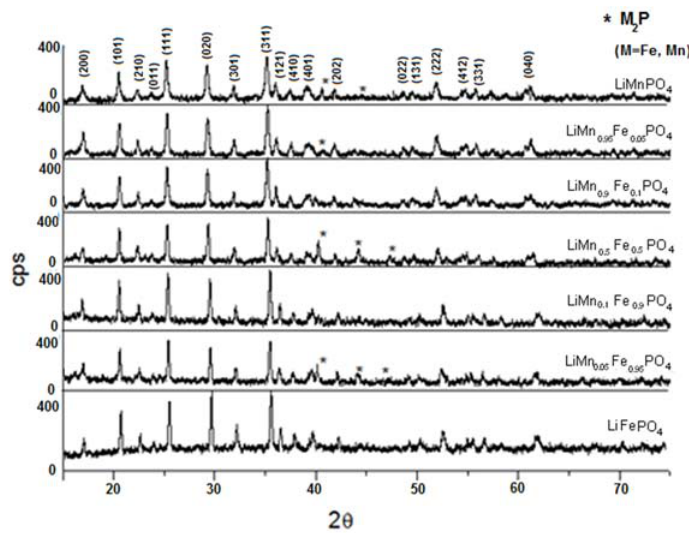
Figure 8. X-ray powder diffraction pattern of LiMn x Fe (1 ´ x) PO 4 (x = 0; 0.05; 0.1; 0.5; 0.9; 0.95; 1).